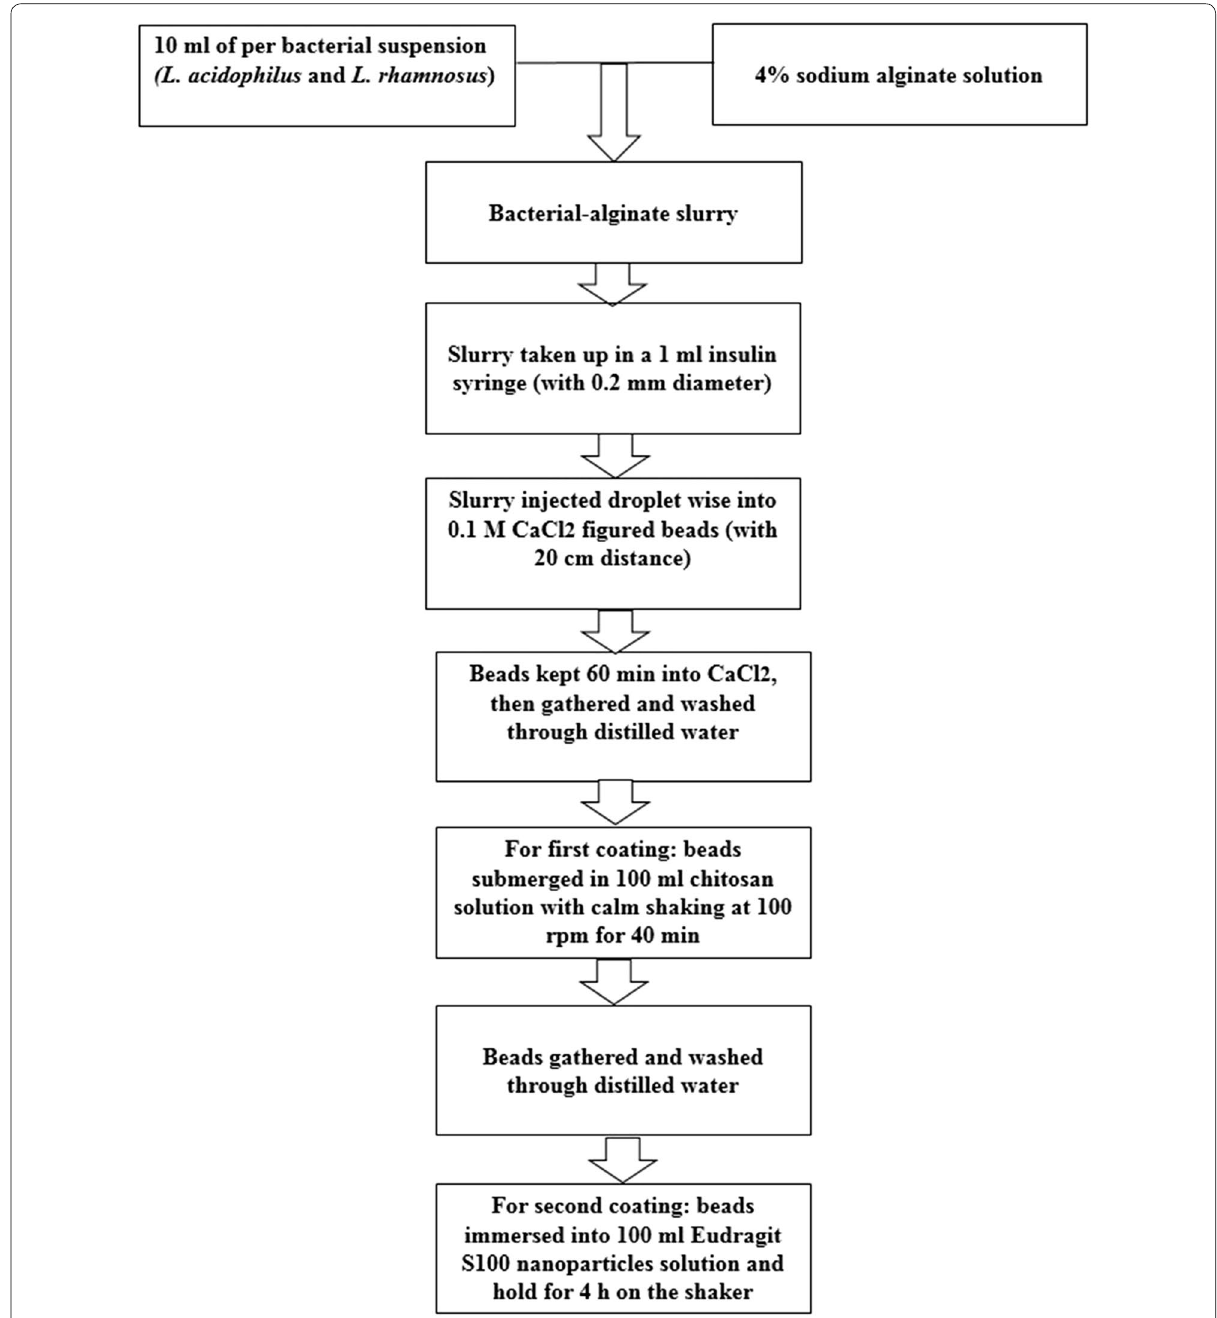
Fig. 1 Schematic representation of the encapsulation of probiotic bacteria in calcium alginate chitosan and Eu S100